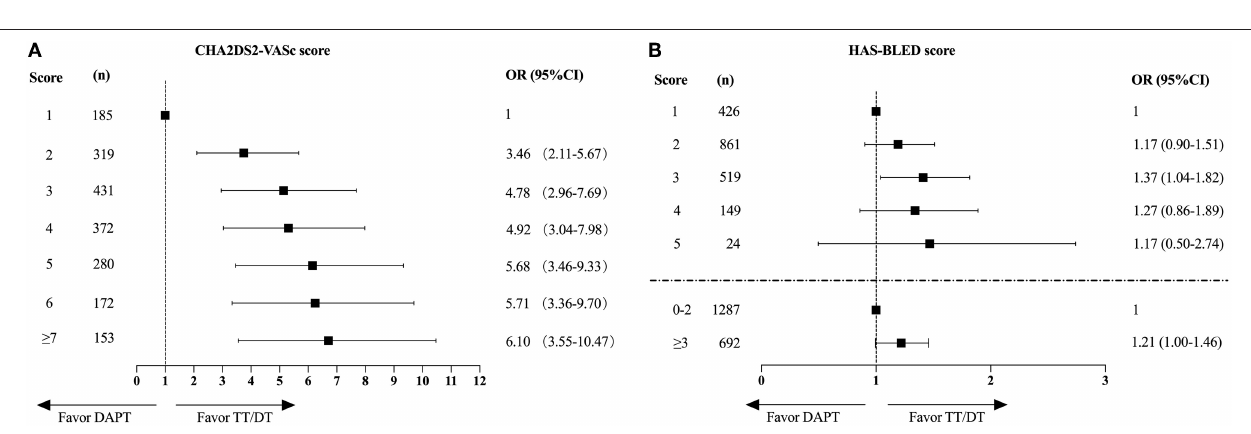
and four pivotal NOAC-based RCTs (11–14), guidelines and consensus documents updated from the North American (16, 17), European (7, 15), and Chinese (18) recommended combined therapy with short-course TT and following DT in patients with NVAF and ACS/PCI. Besides, NOACs are preferred over VKA, and clopidogrel is the most advocated P2Y12